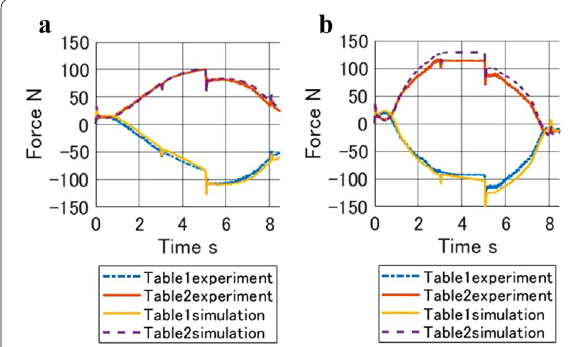
Fig. 10 Results of simulation and comparison with experimental results in control method 1. a Case1-1, b Case1-2